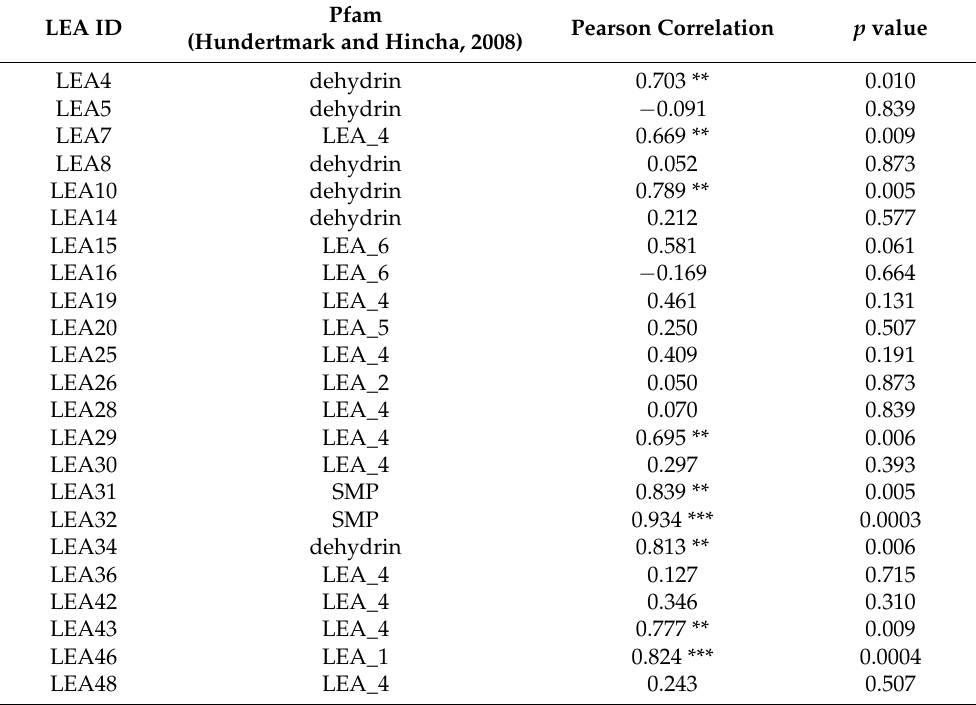
Table 2. Pearson correlation between the abundance of LEA proteins and their corresponding transcripts. LEA proteins with missing means mass spectral LFQ intensities in more than two observed time points were excluded from analysis. Levels of significance of the correlations are indicated by asterisks (** p < 0.01; *** p < 0.001). Pfam Pearson Correlation p value LEA ID (Hundertmark and Hincha, 2008) LEA4 dehydrin 0.703 ** 0.010 LEA5 dehydrin − 0.091 0.839 LEA7 LEA_4 0.669 **